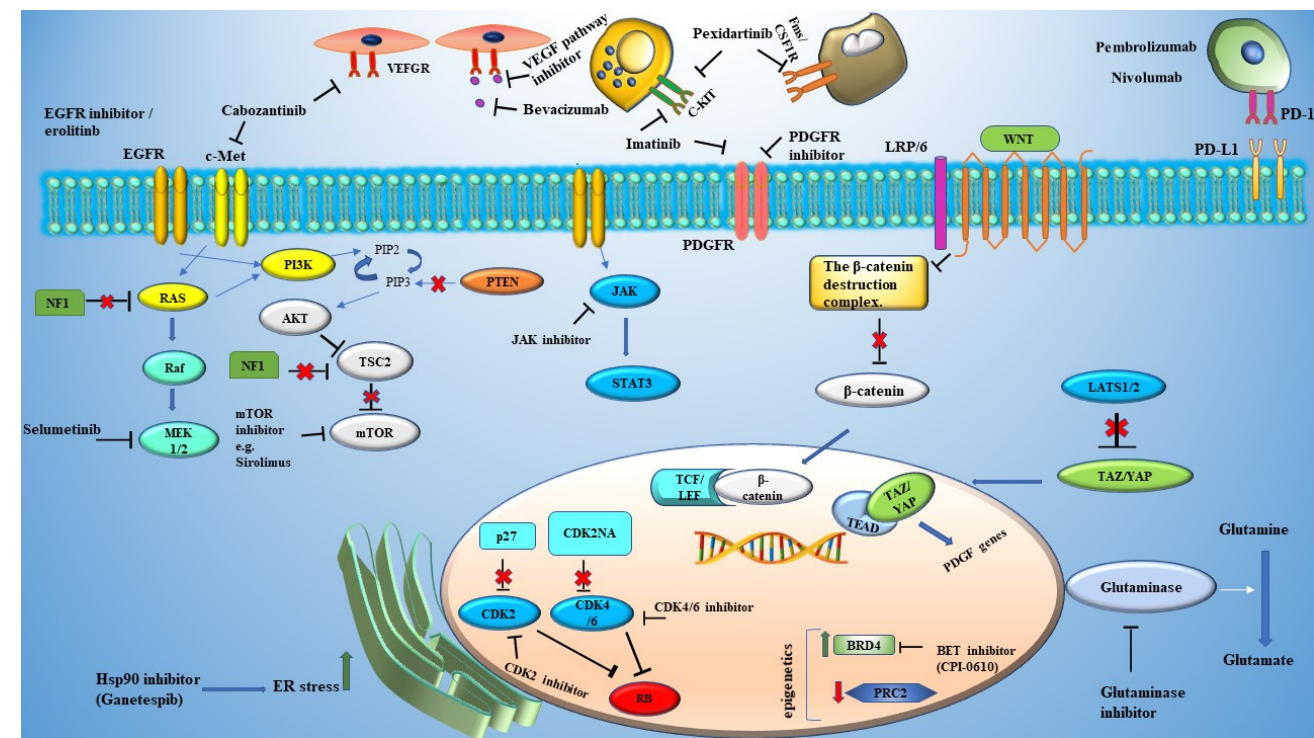
Figure 1. Targetable pathways in NF1. A plethora of signaling pathways has been implicated in MPNST growth and progression. These pathways include growth signaling pathways, tumor suppressors, pathways that are involved in metabolism and development, and pathways that are involved in angiogenesis and immune responses. Pathways and their targeted drugs are represented schematically in this figure. Loss of NF1 protein leads to the activation of RAS/RAF/MEK and TSC2/mTOR signaling pathways, which support cancer cell proliferation. Dysregulation of cell cycle checkpoints, such as CDK2NA and p27, led to abnormal levels of cell cycle kinase CDK4/6 and CDK2, which support cancer cell growth and proliferation. Growth receptor aberrations also contribute to MPNST pathogenesis. Examples of the aberrant receptor signaling that can be targeted are EGFR, c-Met, and PDGFR. Some signaling pathways that are involved in cell development and stemness have been implicated in MPNST development. These are represented by the Wnt and Hippo pathways. Targeting tumor microenvironments is another strategy to treat MPNSTs. Drugs that target the tumor microenvironment include bevacizumab, which targets pro-angiogenic VEGF pathways, and imatinib and pexidatrininb which target mast cells and macrophages, respectively, and play pro-tumorigenic role. Immune checkpoint inhibitors are other examples of drugs in this category. Other targets that are represented are involved in metabolism (glutaminase), epigenetic (BRD4), and ER stress (Hsp90).